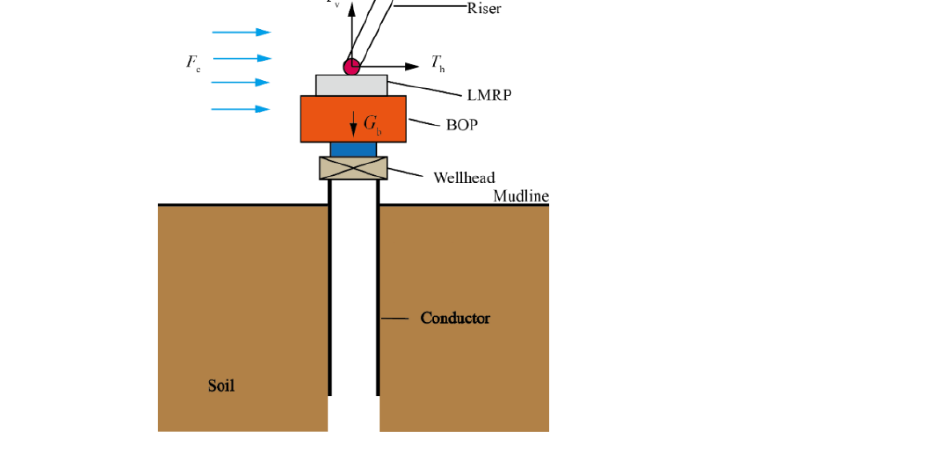
Figure 1. Schematic diagram of the conductor after installation of drilling riser and BOP.